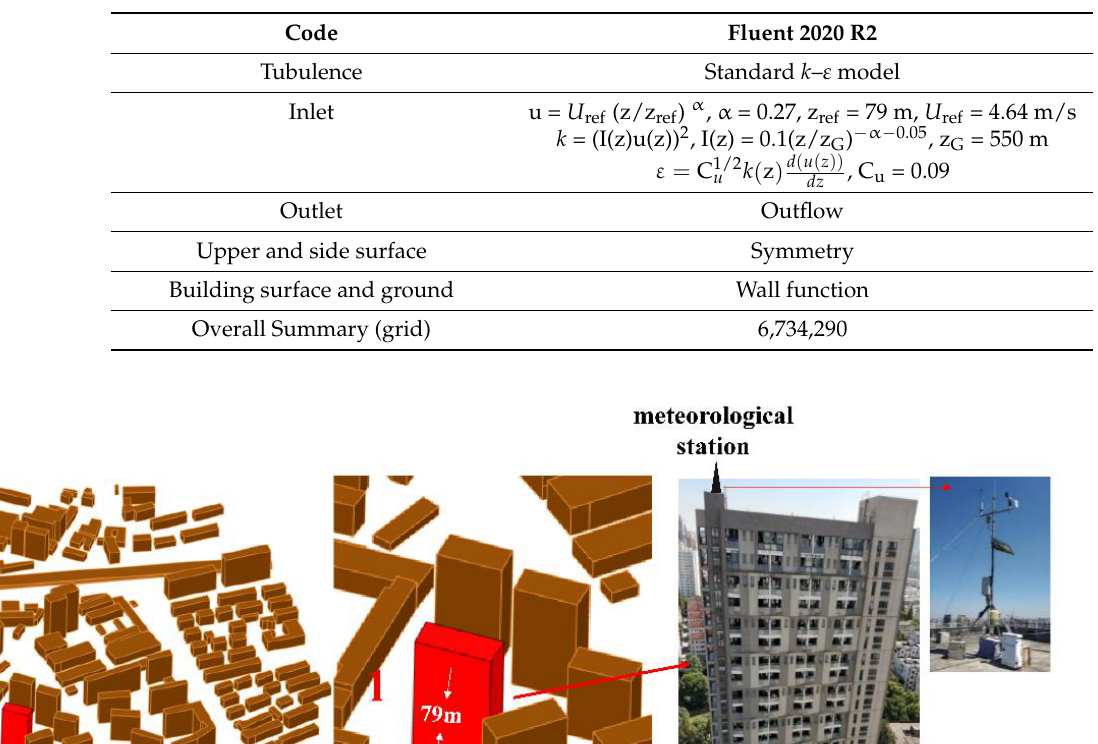
Table 1. Calculation conditions.